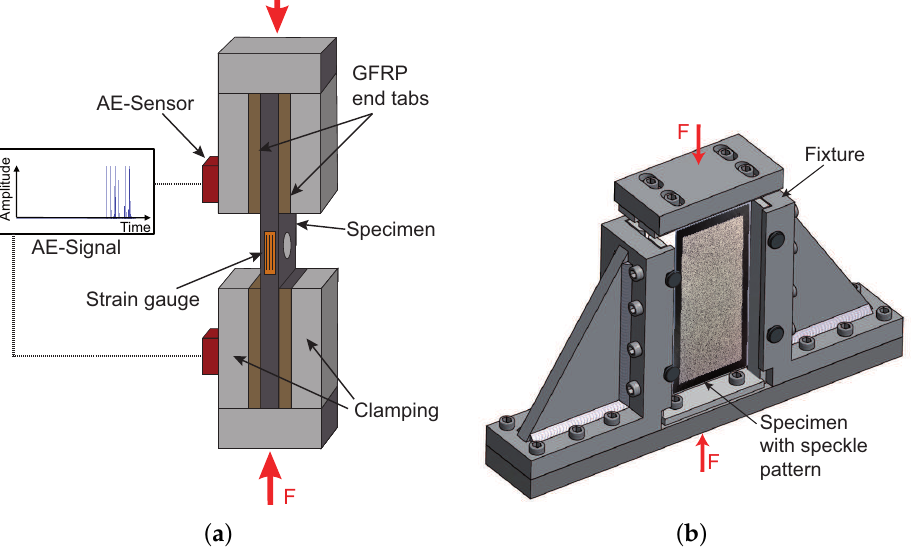
Figure 2. Scheme of the test set-up ( a ) for UNC and OHC tests, here shown for a specimen with a central hole and ( b ) for CAI